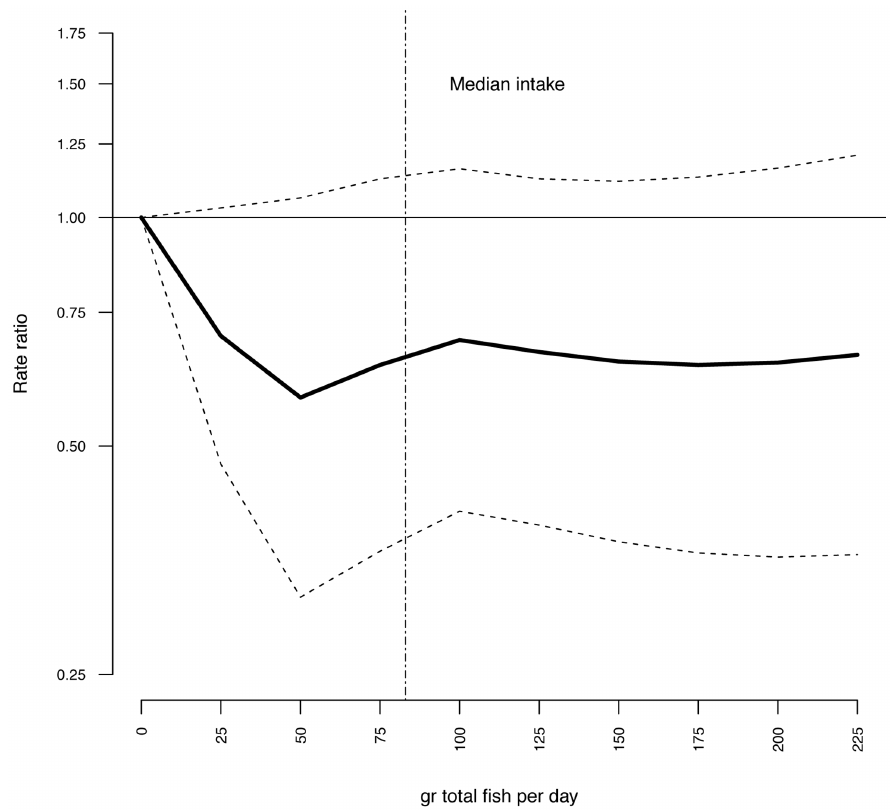
Figure 4. Risk ratios (RR) and 95% CI by total fish consumption. RRs are indicated by the solid line and the 95% CI by the dashed horizontal lines. Numbers are adjusted for BMI, hypertension, smoking status, age and physical activity. Median intake of total fish in the study group is indicated by the dashed vertical line.